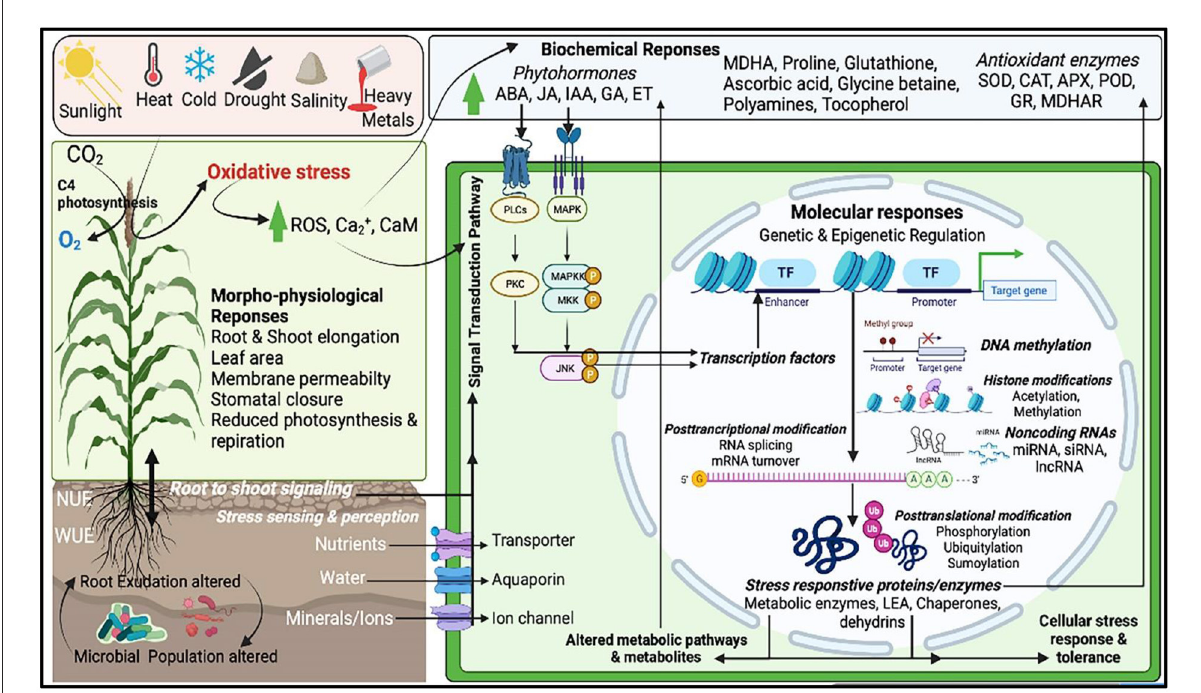
FIGURE2 A schematic framework of abiotic stress response sensing, signaling and regulation in millet cells. Abiotic stresses alter morphophysiological, biochemical and molecular processes and also by modulating the rhizosphere properties and functions in millets. Millet cells can sense and perceive stress signals in several cellular compartments through signaling receptors and activate the signaling cascade through signal transducers (e.g., secondary messengers such as Ca + 2 ROS, phytohormones, polyamines etc.). These signaling messengers trigger the molecular regulatory pathways involving both genetic and epigenetic factors such as post-transcription and post-transactional modifications via DNA methylation, histone modifications and non-coding RNAs activities. Stress signals activate the stress responsive transcription factors which then regulate the stress inducible gene and protein expression. These stress induced functional protein and enzymes have direct role in metabolism and stress adaptation and